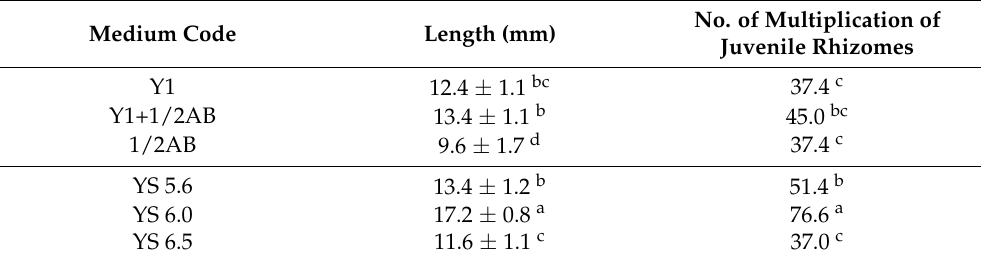
Table 5. Effect of different basal salt media and pH on growth and proliferation of G. elata juvenile rhizomes after 4 months in